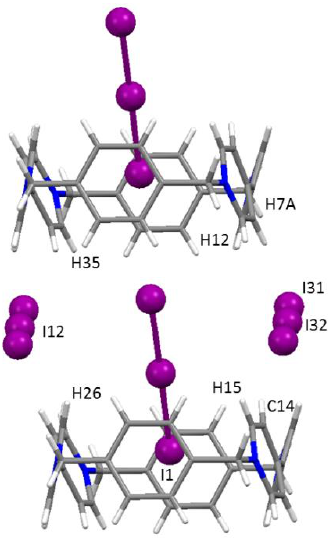
Figure 1. Column of macrocycles and triiodides growing in the a crystallographic direction in the I 3 @BB(I 3 ) 3 · 2DMSO crystal structure.